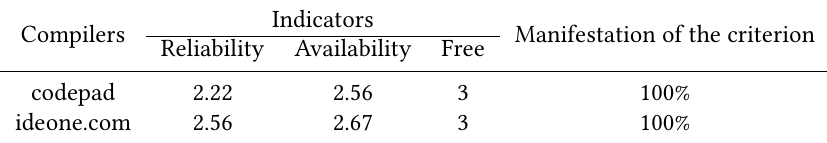
Table 1 Design criterion for web-oriented compilers and its indicators.